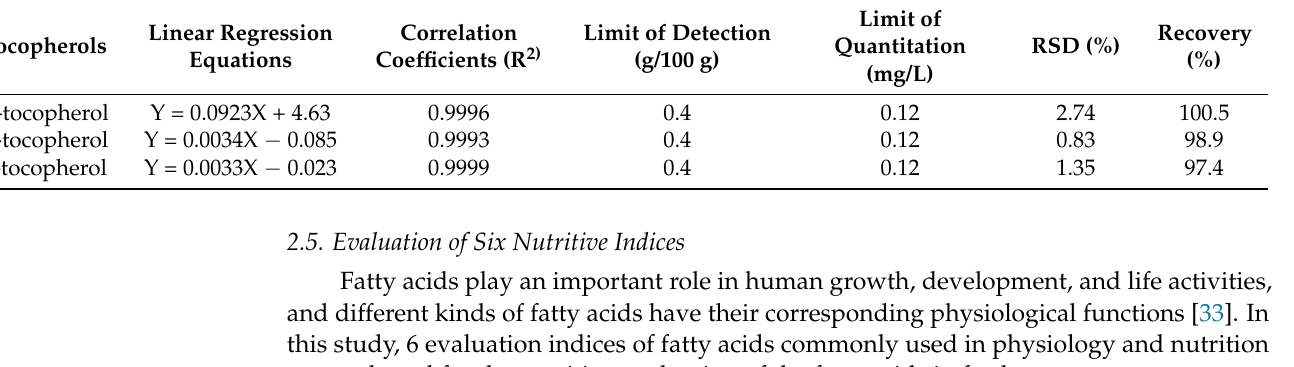
Table 2. Linear regression equations, correlation coefficients, LOD, LOQ, instrument accuracy, and recovery of